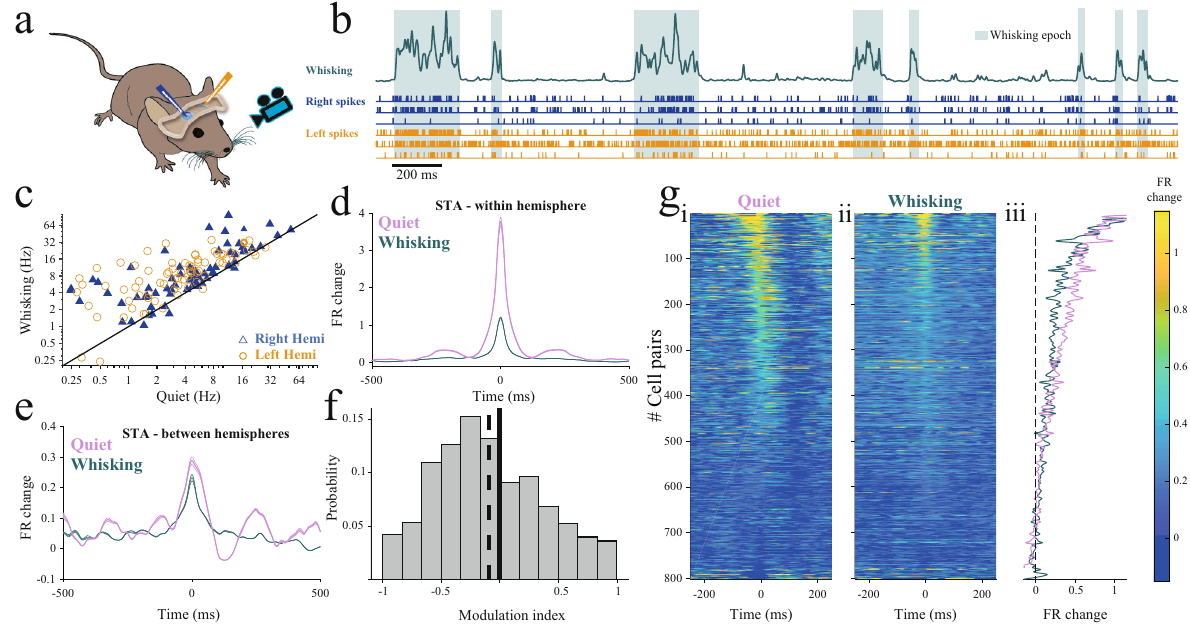
Fig. 1 Interhemispheric correlations are reduced during whisking. a Schematic diagram of the recording session. b An example of an extracted whisking signal and the associated states. Automatically detected whisking epochs (Methods) are marked by teal background. Below are three examples of raster plots of simultaneously recorded units in the right (blue) and left (orange) hemispheres. c Mean fi ring rates during whisking compared to quiet epochs for all the recorded neurons ( p < 0.001, n = 141 neurons, WSRT). d Population average of the spike-triggered averages (STA) calculated for all combinations of cell pairs within hemisphere during quiet and whisking states (mean (line) ± SEM (shaded), p < 0.001, n = 850 pair combinations, 6 animals, WSRT). e Population average of the spike-triggered averages, calculated for all combinations of cells pair across hemispheres during quiet and whisking states (mean (line) ± SEM (shaded), p < 0.001, n = 800 pair combinations, WSRT). For d and e shuf fl ed spike-triggered averages were subtracted (see Methods). f Distribution of state modulation indices de fi ned as the difference between peak STA activity during whisking epochs and quiet wakefulness divided by their sum, calculated for all combinations of cells pair across hemispheres (dashed line marks mean modulation index). g i – ii Right and left panel depict STAs between hemispheres showing all pairs during quiet wakefulness (i) and whisking (ii). Both panels are ordered identically, based on mean peak STAs obtained from both states. g iii Superposition of the distribution curves of the average peak for whisking (teal) and quiet wakefulness (pink) for all